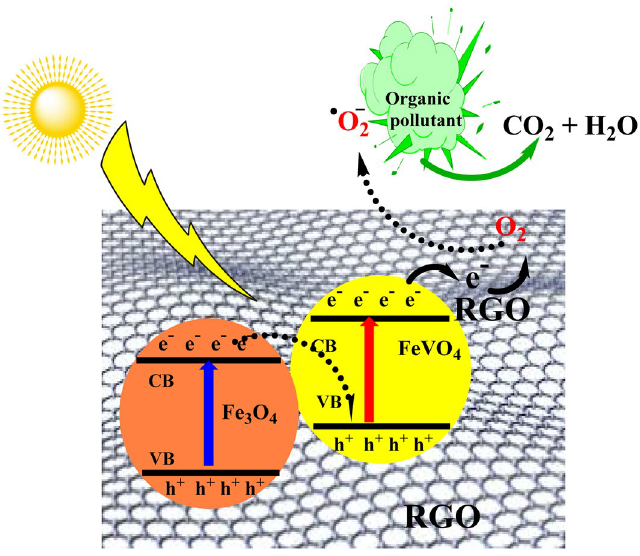
Figure 8. Postulated mechanism of electron transfer in xRGO/Fe 3 O 4 –FeVO 4